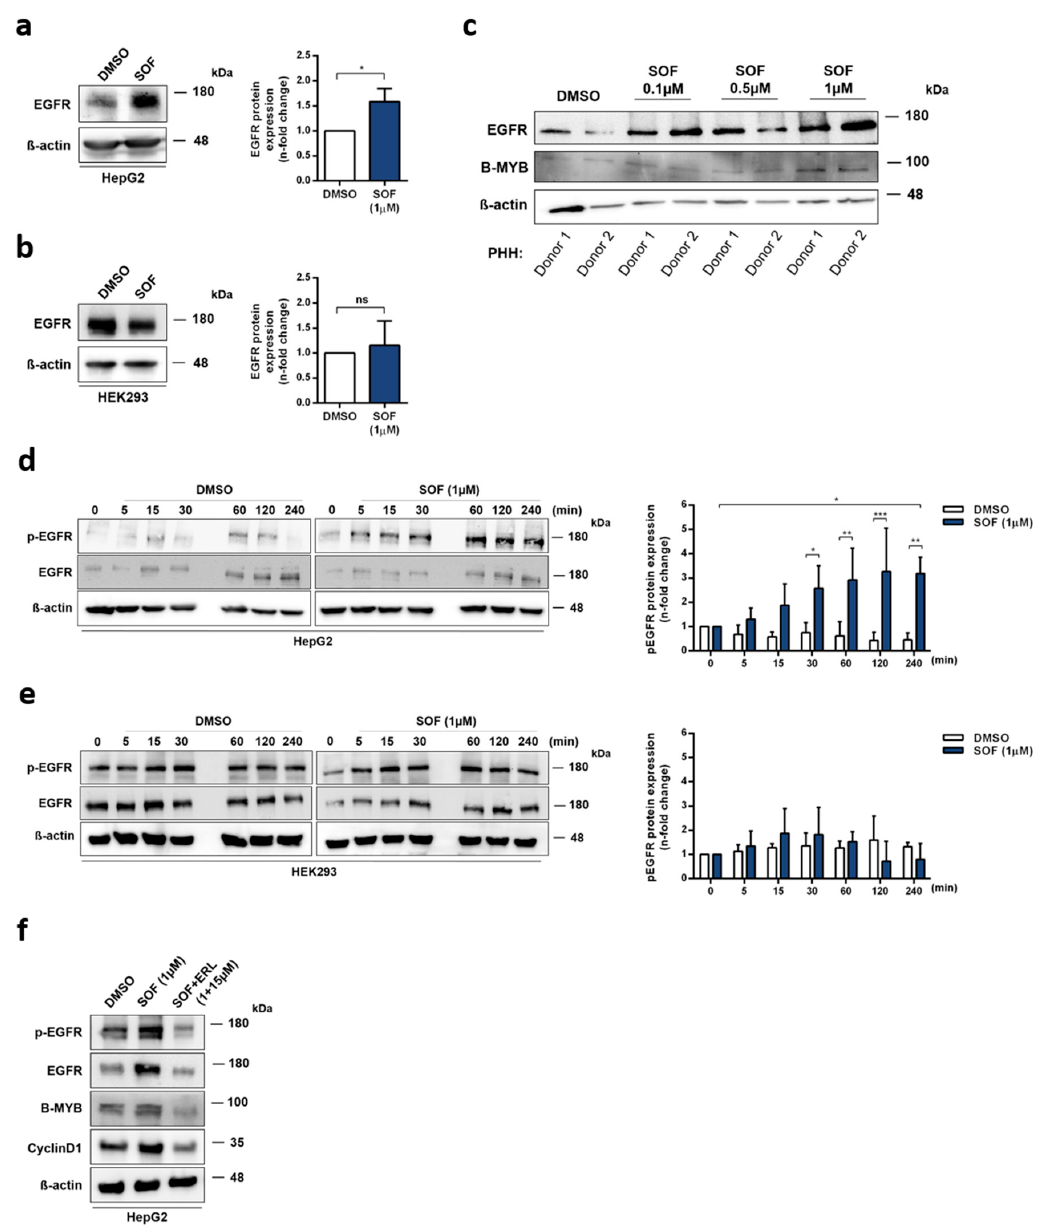
Figure 3. Sofosbuvir increases the expression and activation of EGFR. ( a , b ) EGFR protein levels after SOF treatment were identified by immunoblot analysis. One representative immunoblot is displayed. EGFR expression is presented in the bar graphs as a fold change relative to the DMSO control (mean + s.d. from three biological replicates). ( c ) PHHs were incubated with rising concentrations of SOF for four days. EGFR and B-MYB protein levels were evaluated by immunoblot analysis. One representative immunoblot of two independent experiment is displayed. ( d ) HepG2 and ( e ) HEK-293 cells were starved for 24 h prior to SOF treatment. Protein levels of the phosphorylated form of EGFR (pEGFR) were assessed at the depicted time points by immunoblot analysis. One representative immunoblot is presented. pEGFR expression is shown as a fold change in relation to time point 0 (mean + s.d. from three biological replicates). ( f ) EGFR, pEGFR, B-MYB, and Cyclin D1 protein levels after treatment with SOF and SOF in combination with the EGFR inhibitor, erlotinib (ERL), were identified by immunoblot analysis. One representative immunoblot of two independent experiments is shown. Statistical significance was determined through an unpaired t -test ( a , b ), paired t -test (d, time point 0 vs. 240 min), and two-way ANOVA ( d , e ). ns: not significant; * p ≤ 0.05; ** p ≤ 0.01; *** p ≤